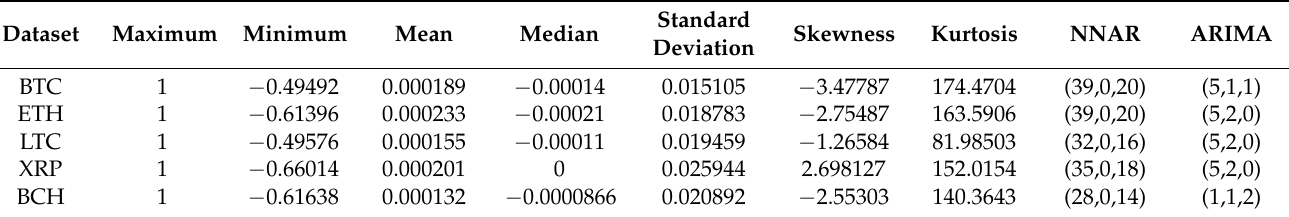
Table 2. Descriptive statistics for log return of BTC, ETH, LTC, XRP and BCH.